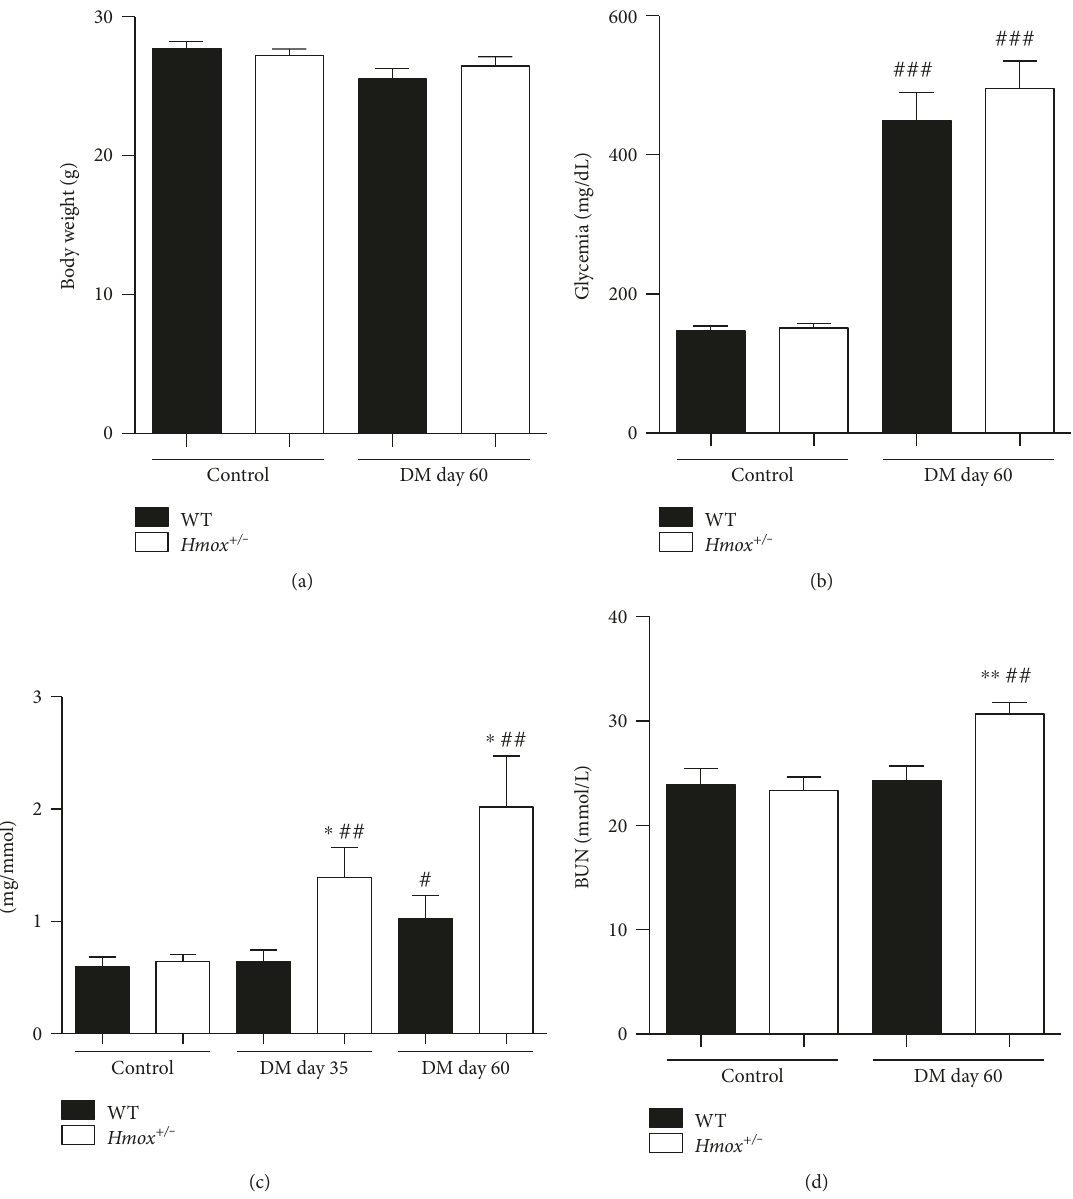
Figure 1: Hmox1 de fi ciency sensitizes mice to diabetic nephropathy development. Body weight (a), fasted blood glycemia (b), microalbuminuria (c), and blood urea nitrogen (BUN) (d) in 20-week-old WT, Hmox1 +/ − , WT diabetic, and Hmox1 +/ − diabetic mice. n =10 to 12 mice. ∗ and ∗∗ indicate the statistical signi fi cance between Hmox1 +/ − versus respective WT, that is, Hmox +/ − DM versus WT DM and Hmox +/ − control versus WT control. #, ##, and ### indicate the statistical signi fi cance between the same genotype versus respective control, that is, Hmox +/ − DM versus Hmox +/ − control, and WT DM versus WT control. ∗ and # indicate p < 0 05 ; ∗∗ and ## indicate p < 0 01